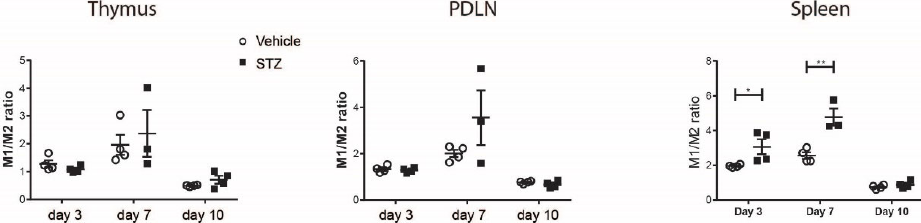
Figure 2. The kinetics of M1/M2 ratio. M1/M2 ratio in the thymi, PDLNs and spleens of vehicle- treated or STZ ‐ treated mice. Results are expressed as means ± SEM. Unpaired t -tests were performed for comparisons. * and ** denote p < 0.05 and p < 0.01.